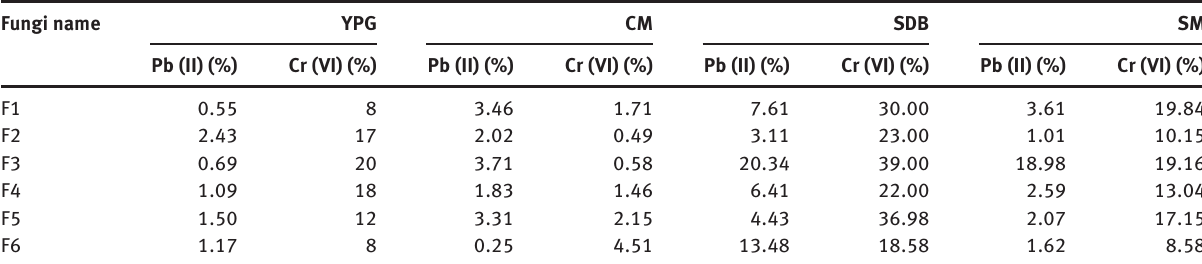
Table 2: Removal efficiency of heavy metals in the two-step